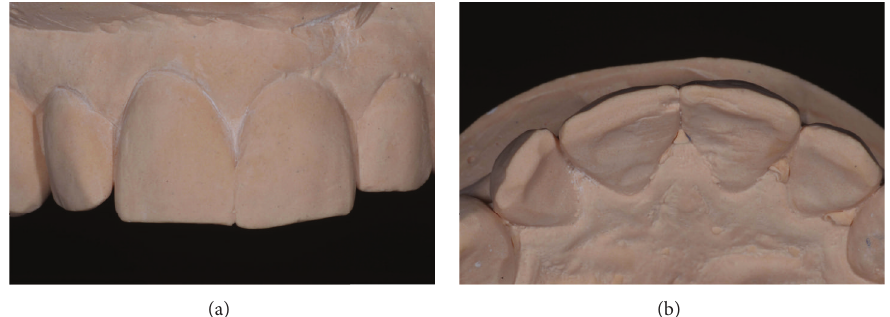
Figure 2: (a) Preoperative cast. (b) The same cast with horizontally sectioned silicon index of wax-up.